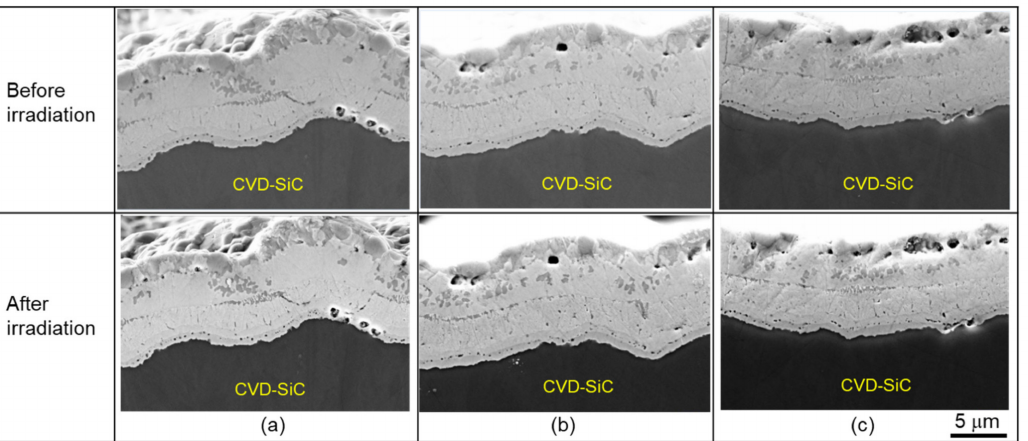
Figure 6. SE images of cross-sectional Ti-Cr multilayer coating surface irradiated with Si 2+ ion at 5.1 MeV and 573 K to fluences of ( a ) 0.95 × 10 19 , ( b ) 9.51 × 10 19 , and ( c ) 2.85 × 10 20 ions /m 2 .